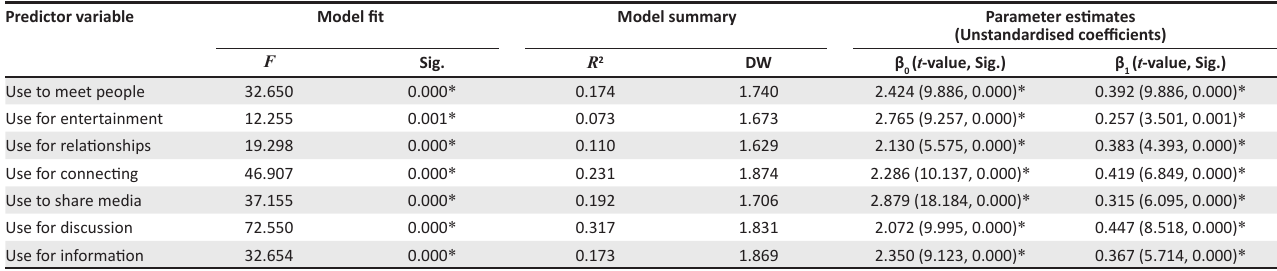
TABLE 4: Simple linear regression model fit statistics, model summary statistics and parameter estimates for Facebook use motivators on Facebook use. Predictor